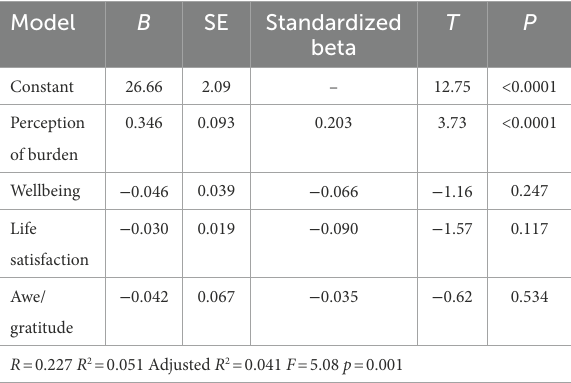
TABLE 3 Results of linear regression analysis between spiritual dryness scale as dependent variable and putatively influencing variables (inclusion